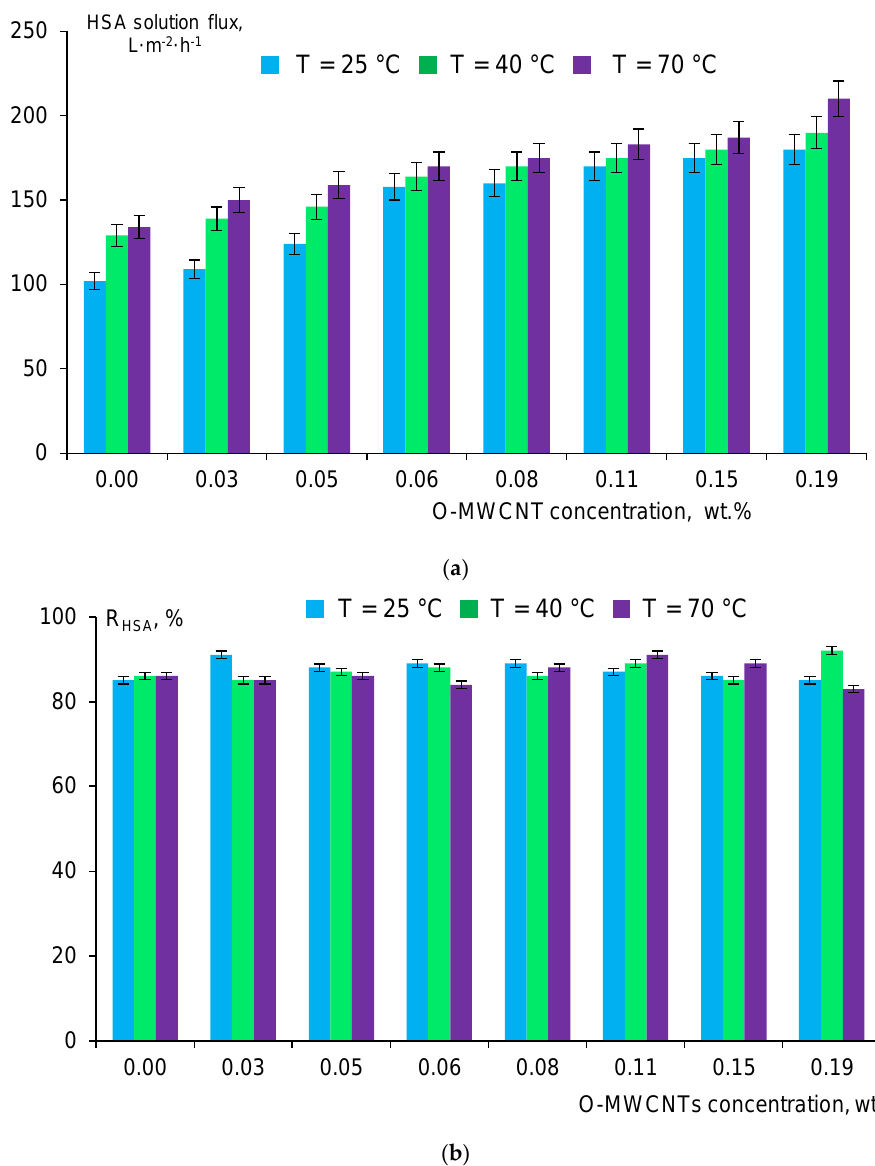
Figure 11. Dependence of 0.05 wt.% HSA solution flux ( a ) and HSA rejection ( b ) on O-MWCNTs concentration in the casting solution, coagulation bath temperature: blue color—T cb = 25 °C; green color—T cb = 40 °C and violet color—T cb = 70 °C.